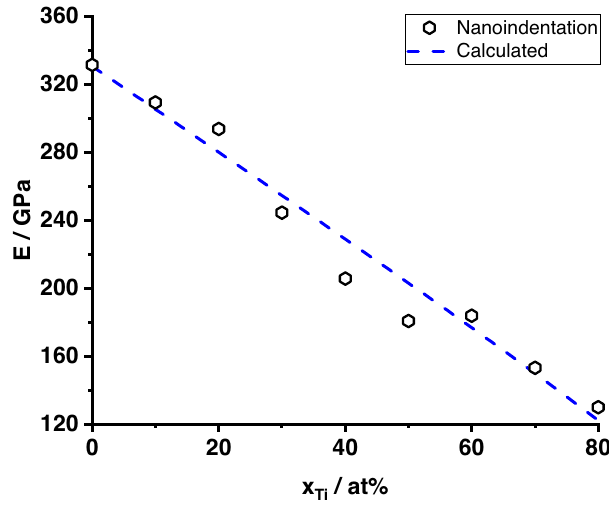
Fig. 2 Experimental and calculated Young ’ s modulus. The Young ’ s modulus measured by nanoindentation (black symbols) and the calculation (blue dashed line) using weighted single crystal constants of Mo 37 and Ti 38 . The standard deviation was smaller than the icon size and therefore